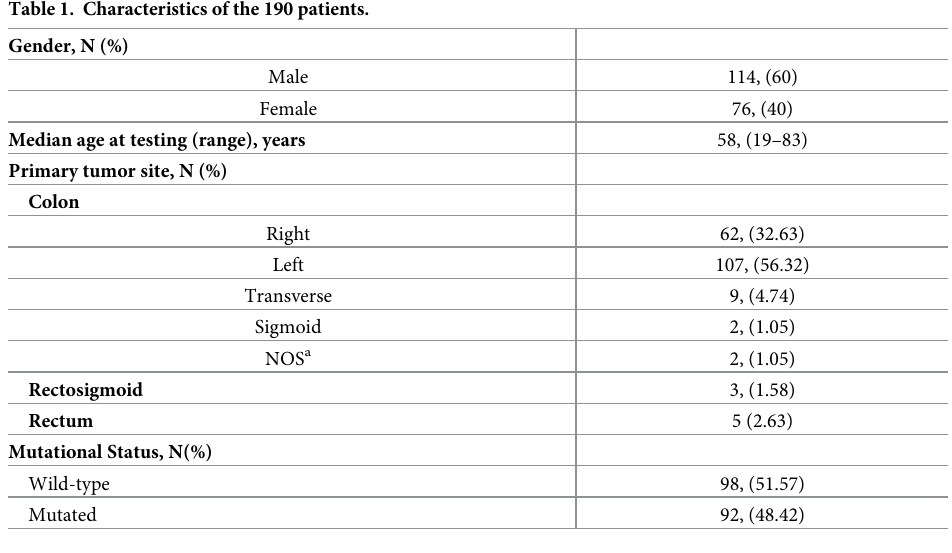
Table 1. Characteristics of the 190